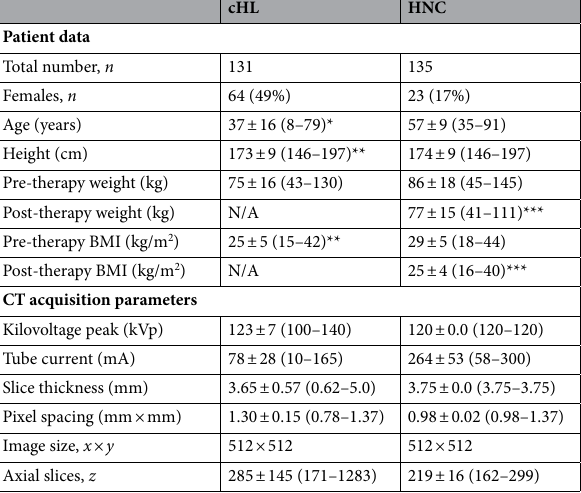
Fig. 1b. Pearson’s correlation coefficient was used a similarity metric between CT image channels and sum of squared differences was used as similarity metric between tissue masks. In the first deformable registration step, the CT image and bone mask were used as image input to complete the alignment of bone. Bone voxels were then constrained before registration of soft tissues in two steps. The first soft tissue registration step used the CT image, inside SAT mask, and adipose tissue mask as input. Constraints were then put on voxels along the outer boundary of the inside SAT mask, before a refined second registration of soft tissue was performed using the CT image, lean soft tissue mask, and adipose tissue mask as input. Finally, constraints were put on non-adipose tissue, excluding the skin, before the body mask was used as input in the last registration step that completed the alignment of SAT. The registration pipeline was implemented in Python. Affine registration was performed with the SimpleE- lastix library 31 and deformable registration was performed with a GPU-accelerated graph-cut based method 32,33 . All steps used a multi-resolution strategy with Gaussian image pyramids, where level i of the pyramid represents an image downsampled by a factor of 2 i in each coordinate direction. Registration was in each step initialized at level 4 and terminated after level 2. Tissue-specific regularization weights were applied in deformable registra- tion with a higher regularization weight applied to tissues with low elasticity (e.g. bone) than to tissues with high elasticity (e.g. adipose tissue). Registration was performed on a desktop computer (64-bit Windows, Intel(R) Xeon(R) W-2102 quad-core CPU 2.90 GHz, 32 GB RAM) with an Nvidia GeForce GTX 1080 Ti graphics card. Between‑subject registration to template space. Between-subject registration was performed of the cHL images and pre-therapy HNC images. Female and male subsets of each dataset were registered separately to a common coordinate space (template space) defined by one image in each subset. Template spaces (subjects) were chosen to meet two criteria; a neutral image positioning and fat body mass close to the median of its subset. Image fat percentage was calculated inside the body mask and used as a surrogate measure of fat body mass for the cHL dataset while available clinical data of pre-therapy CT-derived fat body mass was used for the HNC dataset. Cost function masking was applied to the cHL images to limit registration bias near tumor regions 34 . Masks